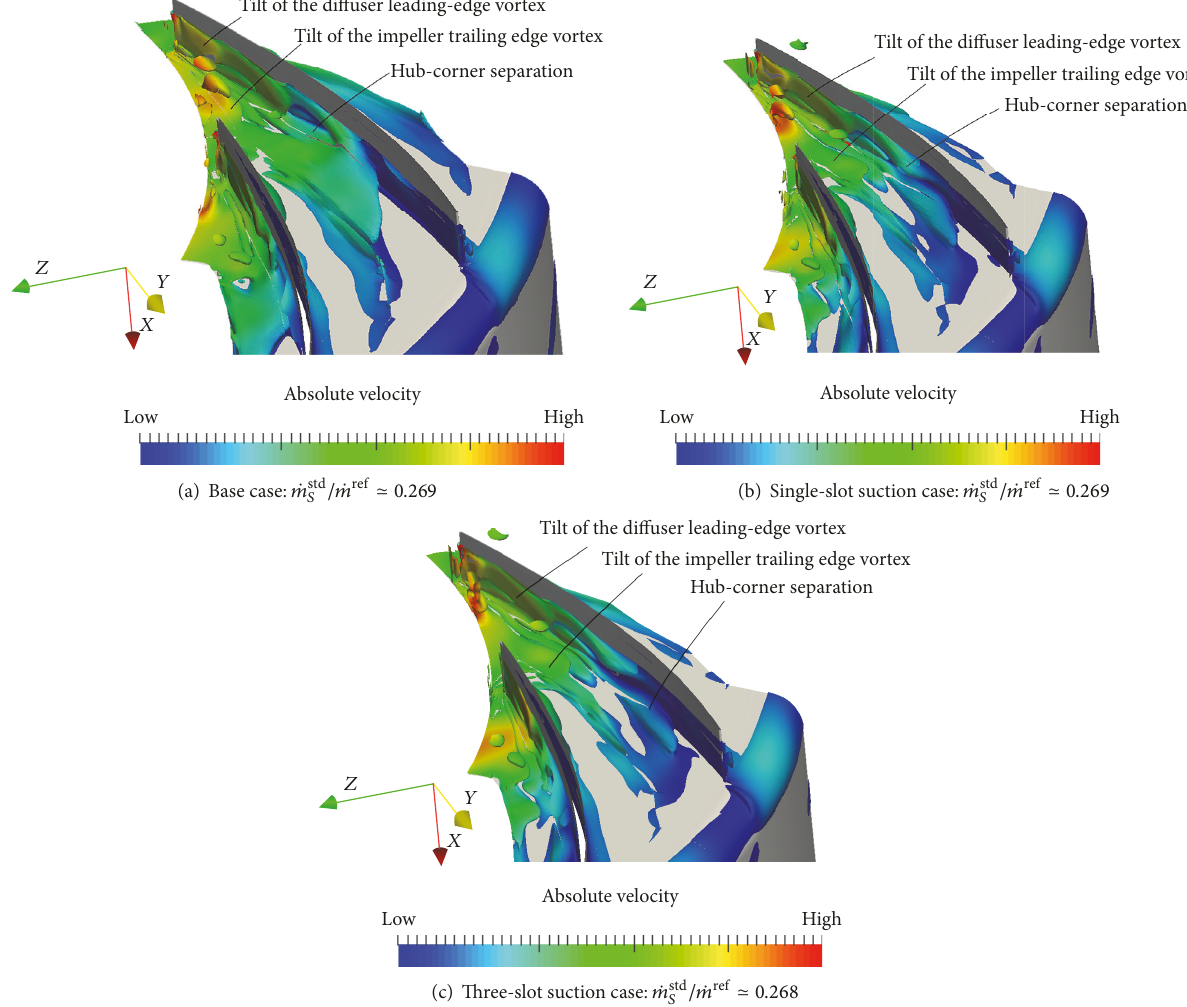
Figure 10: Isocontours of tilt of the Ω 𝑥 vorticity